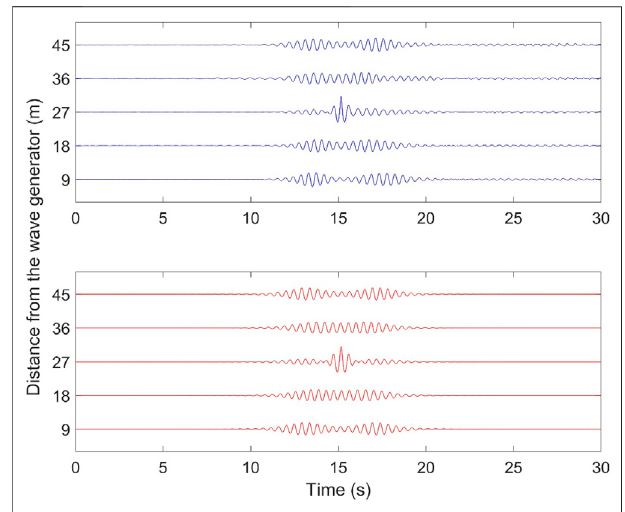
FIGURE 3 | Experimental observation of a degenerate soliton for a (cid:2) 0.006 m, ka (cid:2) 0.12and x p (cid:2)− 27masmeasuredintheHamburgUniversity of Technology fl ume. Top : Water surface as measured by the wave gauges. Bottom : NLSE predictions at the same physical locations using Eq. 10